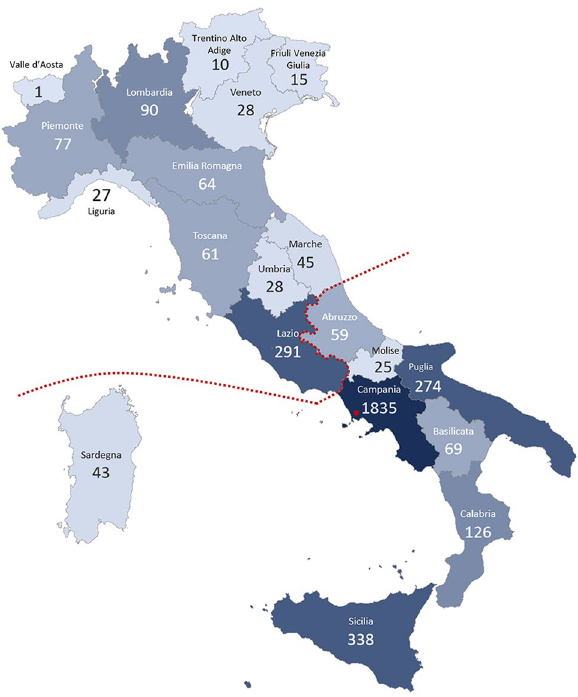
Figure 1. Overview of the geographical representation of the clinic’s cohort. Map of Italy, divided by administrative districts (Regions; delimited by a grey line), depicting the origin of patients followed at the Reference Center for Rare Eye Diseases at the Eye Clinic of the University of Campania ‘Luigi Vanvitelli’ (Naples, Campania Region; red dot). Color intensity indicates the relative number of patients originating from each administrative region. The geographic area corresponding to the Southern Italy and Islands is delimited by a dotted